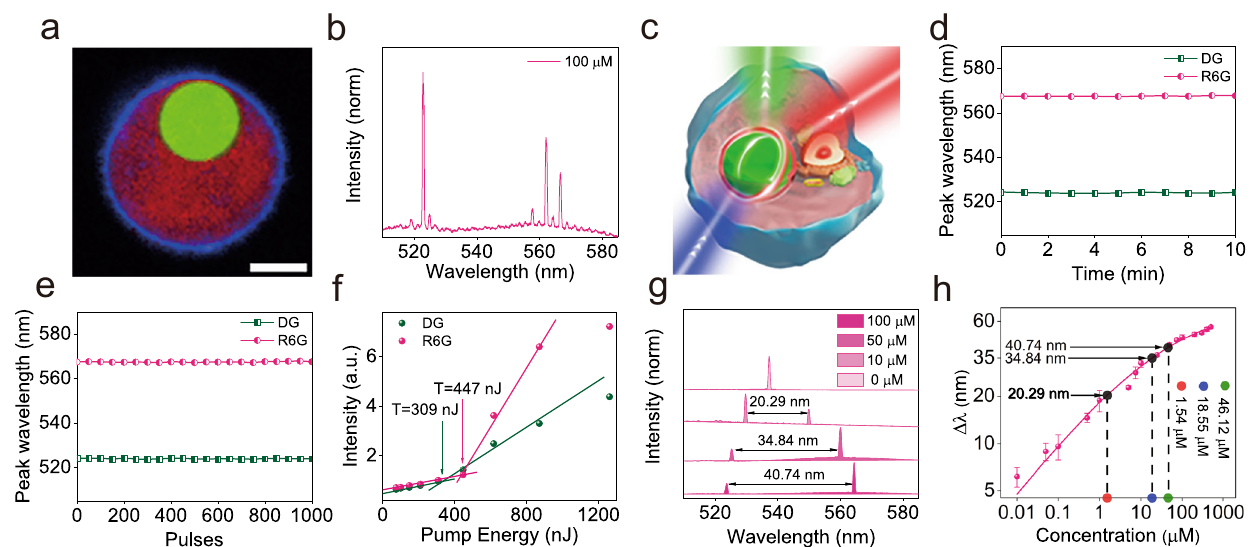
Fig. 5 | Real-time intracellular R6G quanti fi cation. a Image of A T47D cell har- boring a DG (microsphere (green) following incubation with R6G (red) for 5mins. The cell membrane (blue) was stained with CellMask TM . The experiment was repeated independently three times with similar results. Scale bar 10 μ m. b Dual lasing of DG and R6G within a T47D cell. c Schematic illustration of intracellular dual lasing viaFRET from a cellharboring aFRET-donor doped optical microcavity andimplantedincytoplasmcontainingaFRET-acceptor. d , e Lasingwavelengthsof DG and R6G remain un-shifted following 10mins of continuous pumping ( d ) and 1000 pulses ( e ). f The intracellular lasing thresholds of DG and R6G are 309nJ and